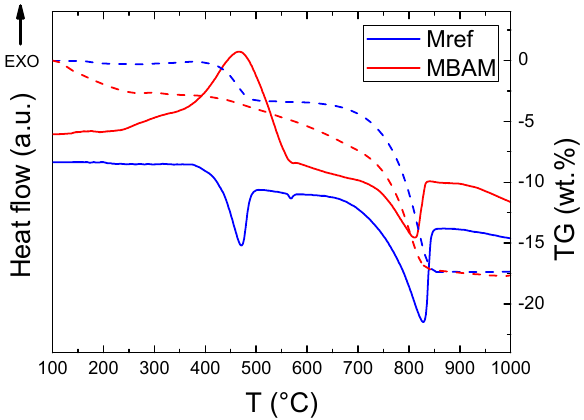
Figure 7. DTA a TG curves of ( A ) M ref and ( B ) MBAM measured in air atmosphere.